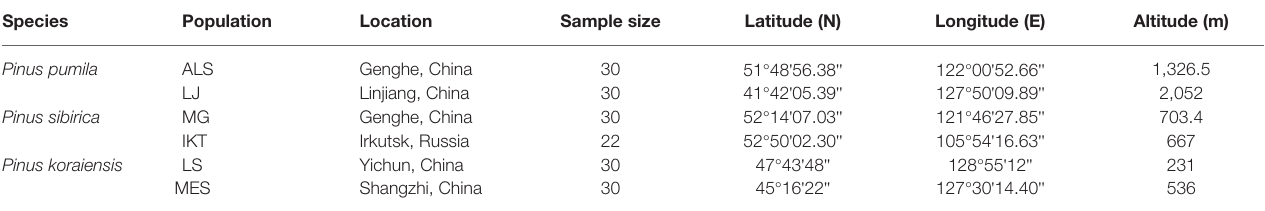
TABLE 1 | Summary of sampled populations of three Pinus species. Species Population Location Sample